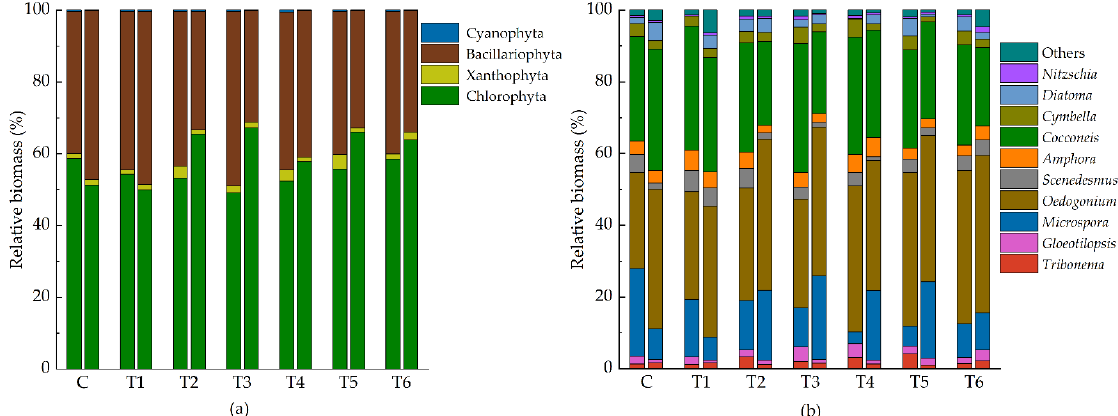
Figure 2. Community composition of relative biomass of epiphytic algae (( a ) at phylum level, ( b ) at genus level). Each group has two histograms (right: Initial, left: 7 d). Abbreviations for groups are the same as in Figure 1.